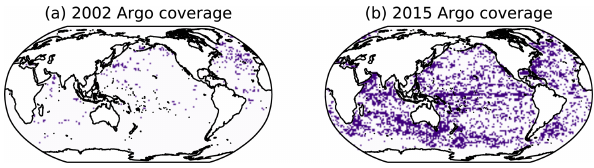
Figure 1. Argo profile distributions consistent with sampling for (a) year 2002 and (b) year 2015. Coloured regions indicate bins that have at least 6 months of observations in the given